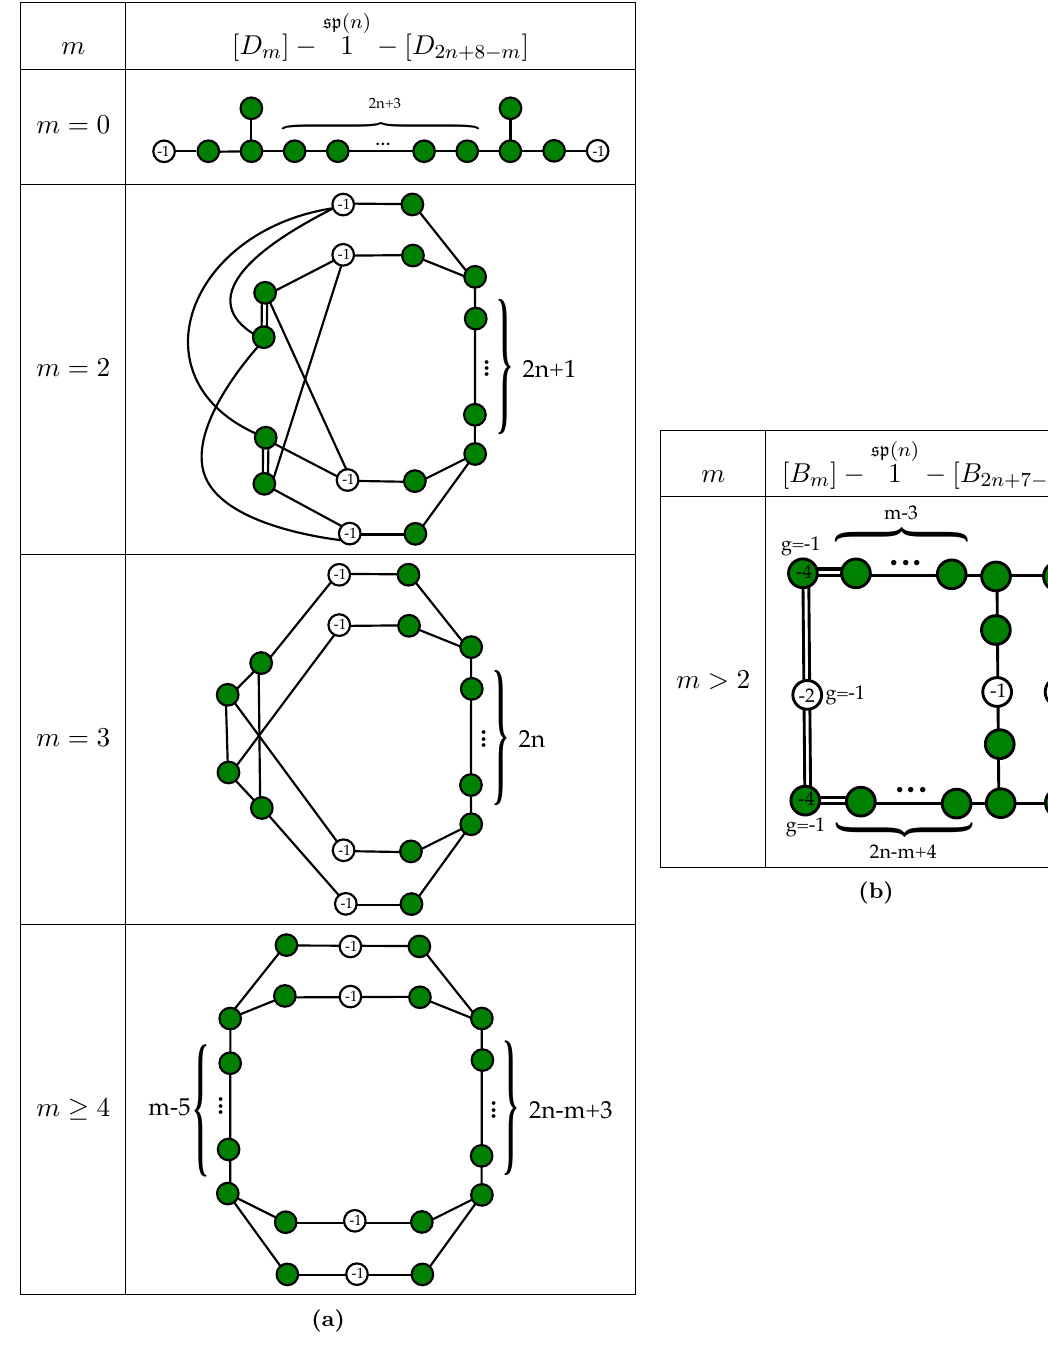
Table 9. CFDs for sp ( n ) on a ( (cid:0) 1)-curve in the description on the tensor branch in terms of